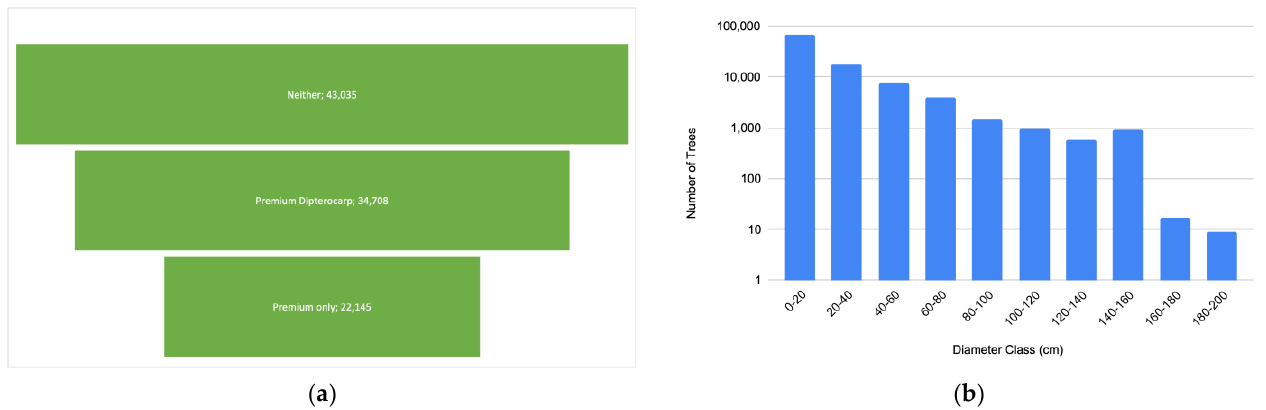
Figure 4. Distribution of trees in the theoretical forest in terms of type ( a ) and DBH ( b ). Submodels